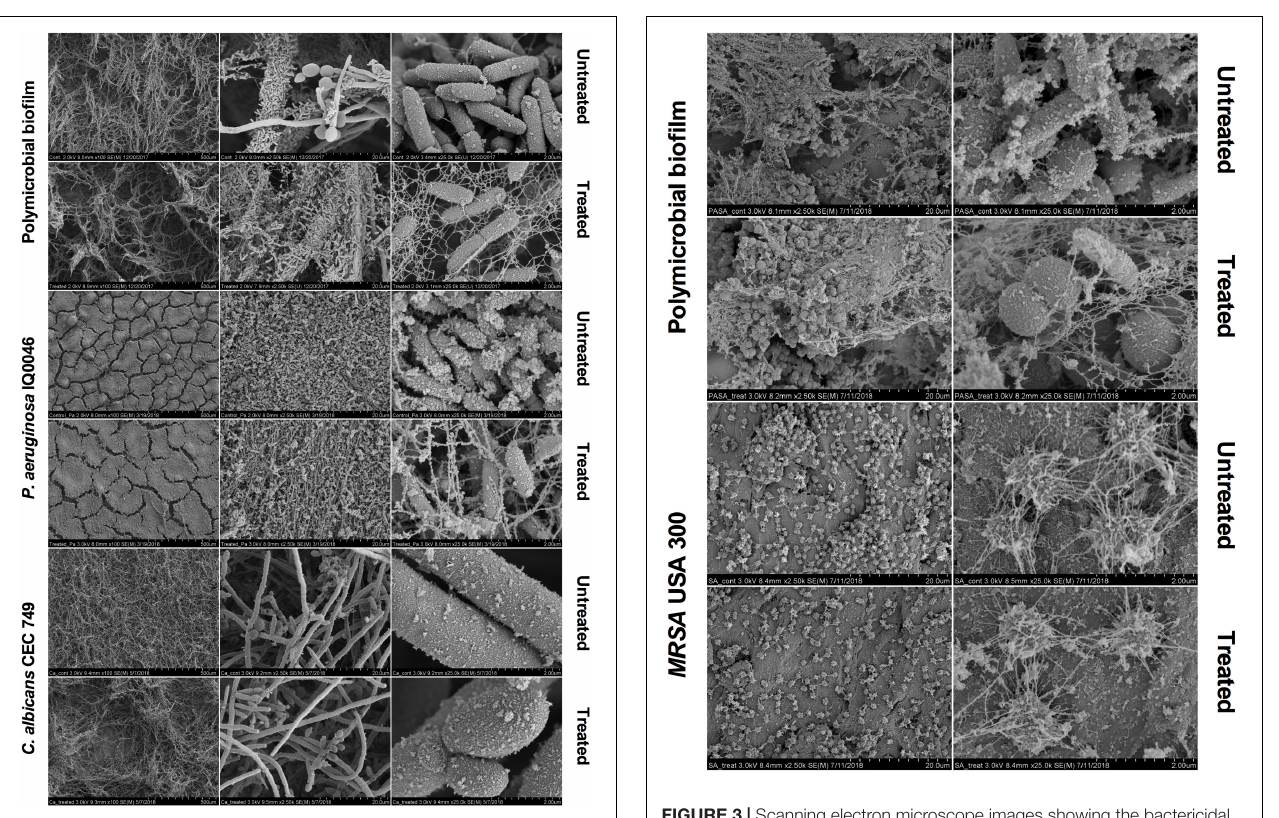
FIGURE 2 | Scanning electron microscope images showing the cytotoxic activity of aBL at 405 nm in P. aeruginosa IQ0046 and C. albicans CEC 749 monomicrobial and polymicrobial biofilms after an aBL exposure of 500 J/cm 2 (92.6 mW/cm 2 and 90 min). Scale bars represent 500, 20, or 2 µ m.